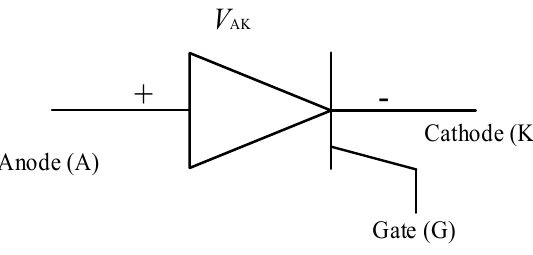
Figure 10. Schematic symbol of a silicon controlled rectifier (SCR) [132]. Figure 11. Schematic symbol of gate-turn-off thyristor (GTO) [134].